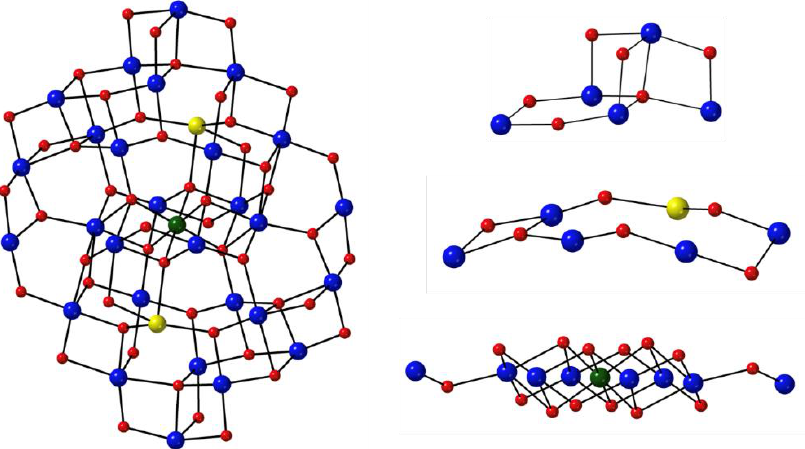
Figure 18. The metal–oxygen core (left) and the four types of constituent layers (right) along the crystallographic c axis. H atoms have been omitted for clarity. Color code: Mn II yellow, Mn III blue, Mn IV olive green, O red. Modified from reference [133].